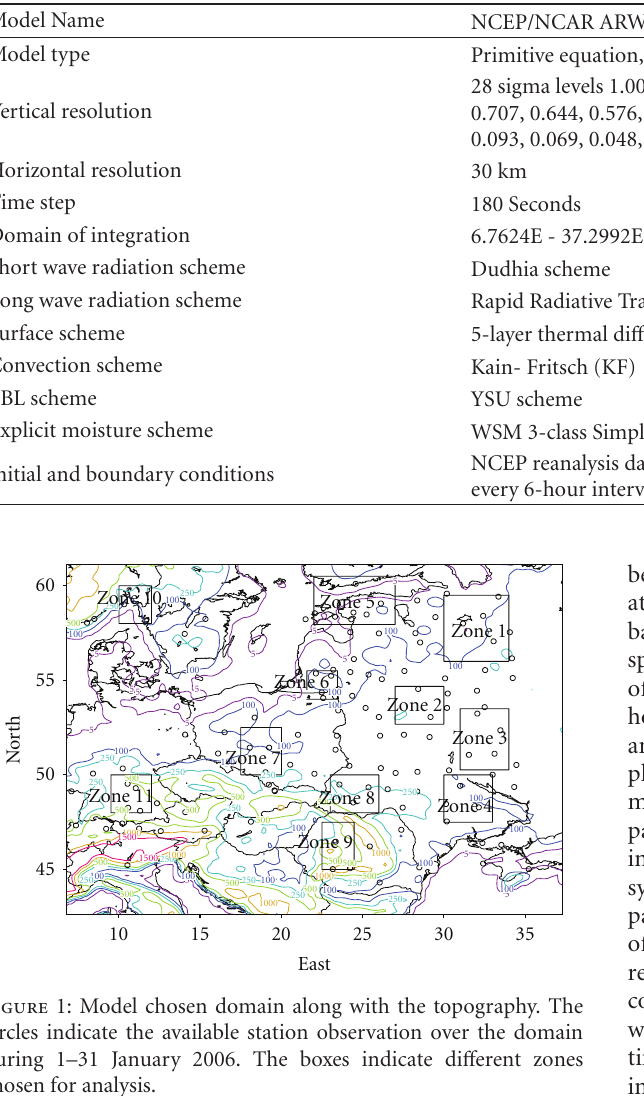
Table 1: Details of the ARW model.